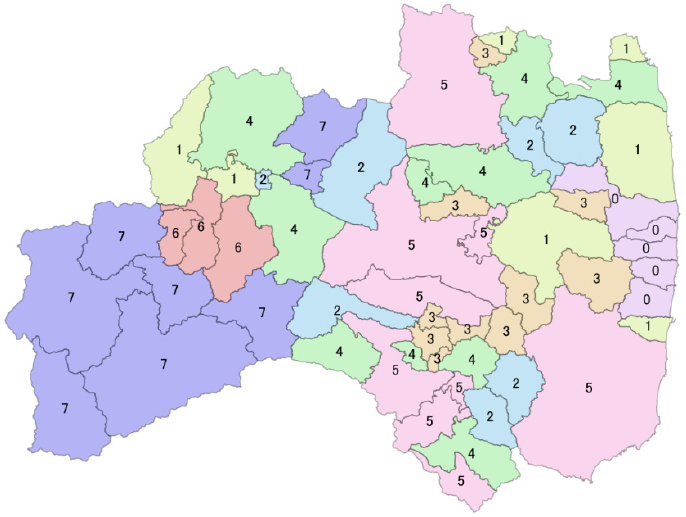
Figure 5. Municipalities with similar road recovery speeds were divided into seven clusters.